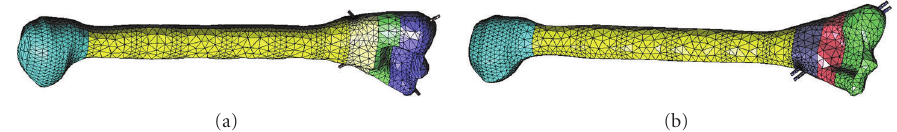
Figure 7: Generated finite element meshes for parallel and crossed K-wire fixation treatment